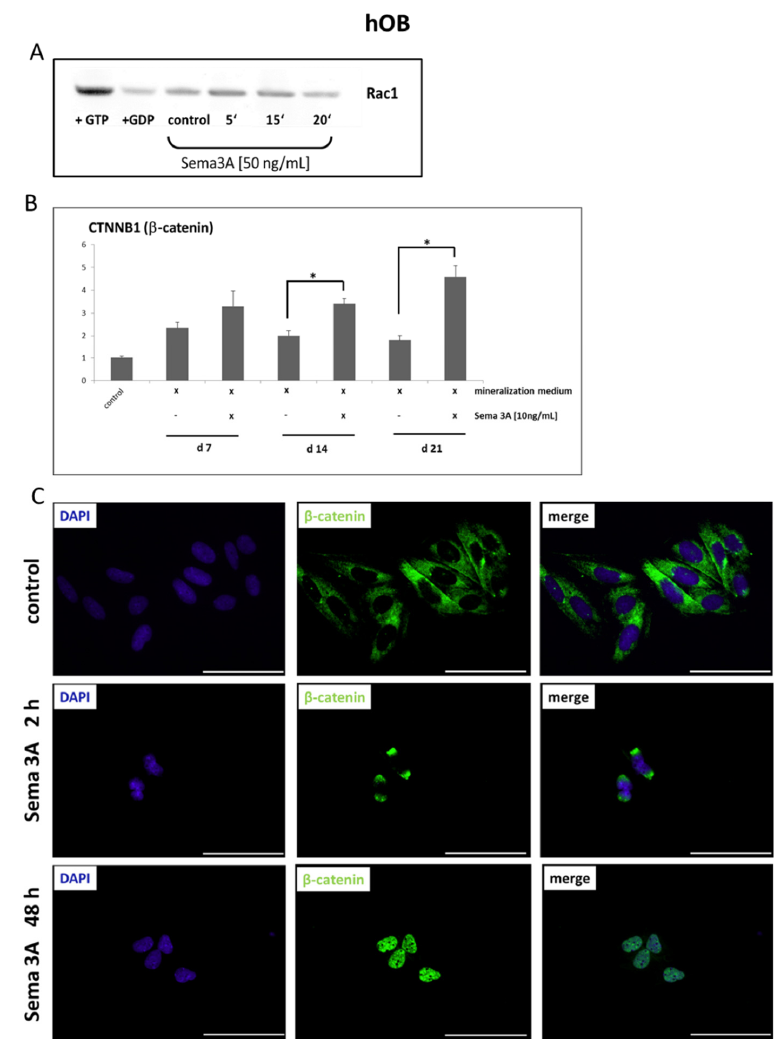
Figure 6. Semaphorin 3A stimulation of human primary osteoblasts of the alveolar bone (hOB) is associated with Rac1GTPase activation, as well as transcriptional induction and the nuclear translocation of β -catenin: ( A ) Osteoblasts of the alveolar bone were stimulated with recombinant Sema 3A [50 ng/mL] for the periods indicated. Pull down was carried out with GST (glutathione-S-transferase)—CRIP (Cdc42/Rac interactive binding) fusion proteins. A representative Western blot shows that exogenous Sema3A activated Rac1GTPase after 5–15 min. before returning to baseline levels after 20–30 min. ( B ) Populations of primary human alveolar osteoblasts were cultivated with osteogenic differentiation medium with and without the addition of recombinant Sema 3A [10 ng/mL] for 7–21 days. Semaphorin 3A significantly increased the expression of β -catenin (CTNNB1), suggesting a possible contribution of Semaphorin 3A to the osteogenic differentiation of human alveolar osteoblasts. Untreated cells served as controls. Quantitative RT-PCR experiments were carried out in triplicate. Cumulative data of the three cell populations data are given as mean ± SD. * = p < 0.05 vs. control (Kruskal–Wallis one-way analysis of variance on ranks (ANOVA), followed by Dunn’s post-hoc test). ( C ) Primary human alveolar osteoblasts were stimulated with recombinant Semaphorin 3a [250 ng/mL] for up to 48 h. In untreated cells (control, upper panel), β -catenin was mainly located in the cytoplasm. The stimulation with Semaphorin 3A led to a perinuclear accumulation of β -catenin after 2 h (Sema3A 2 h, middle panel). After 48 h, most of the β -catenin was translocated into the nucleus (Sema3A 4 h, lower panel). Representative immunofluorescence staining for β -catenin (green) on hOB. DAPI (blue) = 4’, 6-diamidino-2-phenylindole. Bar = 20 µ